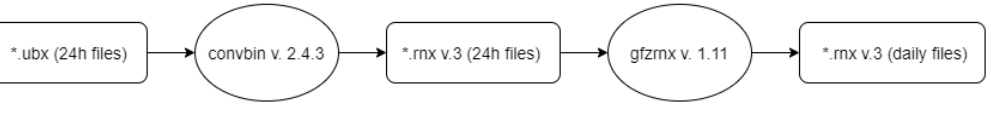
Figure A1. Sketch of *.ubx data format conversion to RINEX version 3.